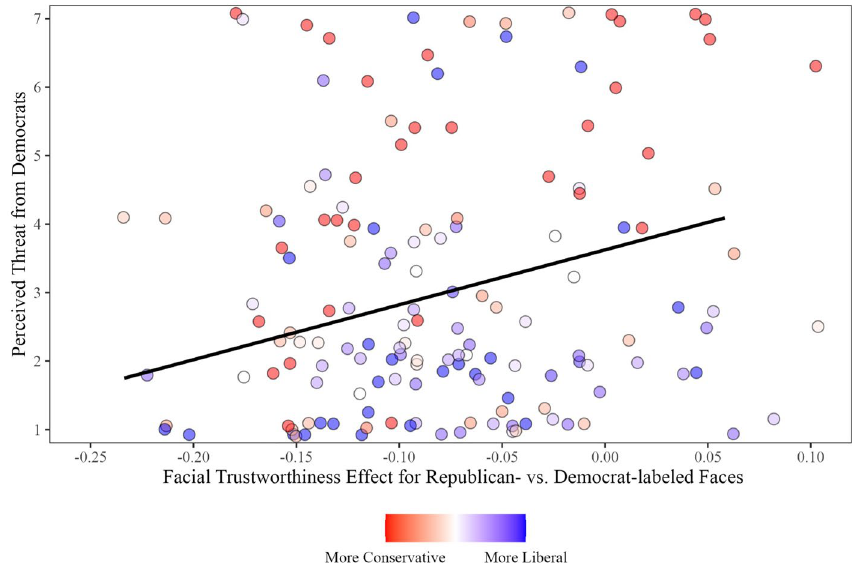
Figure 3. A stronger positive facial trustworthiness effect for Republican-labeled than Democrat-labeled faces positively related to perceived threat from Democrats in Experiment 1. Participants’ own political ideology (standardized composite scores) is represented by the color of the